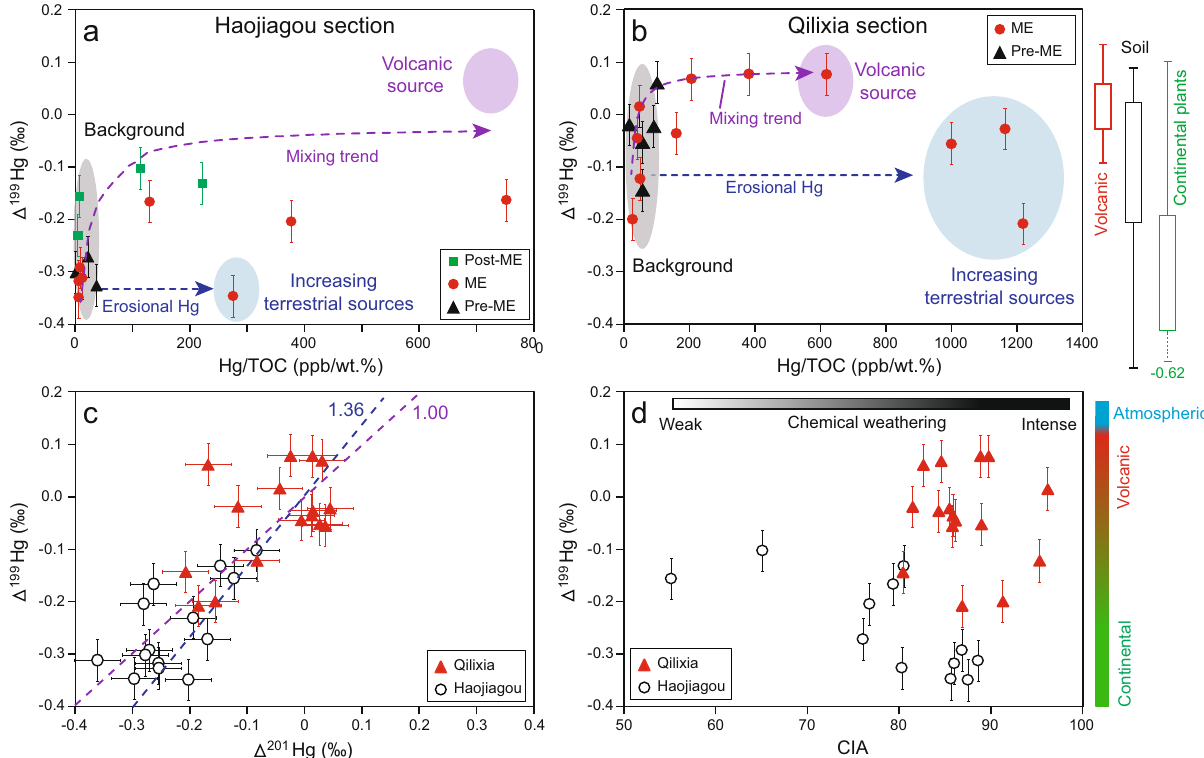
Fig. 3 Crossplot of geochemical proxies. Δ 199 Hg versus Hg/TOC for Haojiagou ( a ) and Qilixia ( b ) sections, as well as Δ 199 Hg versus Δ 201 Hg ( c ) and CIA ( d ) for HJG and QLX sections. The gray, purple, and blue ellipses in ( a ) and ( b ) represent the background, volcanic, and terrestrial endmember sources, respectively. The volcanic endmember is based on the most positive values of MIF ( Δ 199 Hg = ~0.1 ‰ ) and most elevated Hg/TOC values (~600 – 800 ppb/ wt.%) in the study sections, which likely re fl ect dominant volcanic in fl uence. For the terrestrial endmember, we assumed values based on the maximum Hg/TOC (~300 ppb/wt.% and 1000 – 1200 ppb/wt.% for HJG and QLX, respectively) and Δ 199 Hg values similar to the background (~ − 0.3 ‰ to − 0.4 ‰ and − 0.2 ‰ to 0 ‰ for HJG and QLX, respectively). The purple dashed arrows in a and b represent a two-component mixing model between the background (low Hg/TOC, negative Δ 199 Hg) and the volcanic endmember (high Hg/TOC, positive Δ 199 Hg). The blue dashed arrows in a and b represent increasing terrestrial Hg inputs (high Hg/TOC, negative Δ 199 Hg) into the system. The range of Δ 199 Hg values for volcanisms, soil, and continental plants and continents are from Yin et al. 58 . The bars of the Δ 199 Hg and Δ 201 Hg distributions represent standard deviation (2 σ ) values. ME mercury-enriched interval. Source data are provided as a Source Data fi